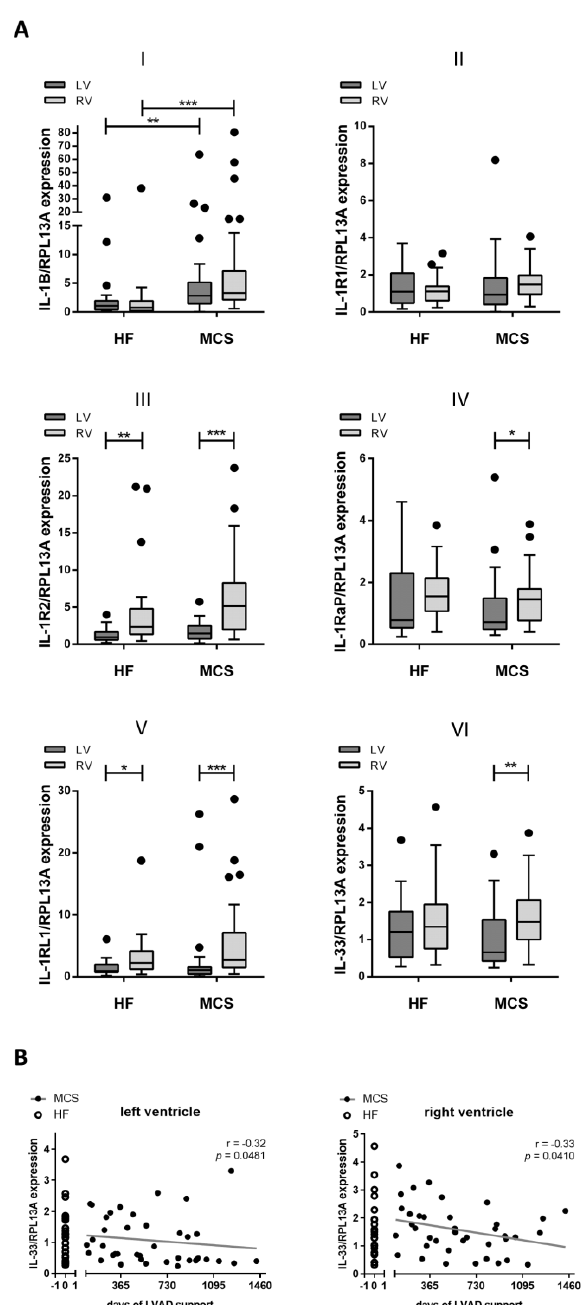
Figure 1. Significantly elevated IL-1B expression due to MCS (mechanical circulatory support). ( A ) Fold change of (I) IL-1B , (II) IL-1R1 , (III) IL-1R2 , (IV) IL-1RaP , (V) IL-1RL1 and (VI) IL-33 mRNA expression levels are displayed for patients with heart failure (HF) or MCS in left (LV) and right ventricular (RV) myocardial tissue. Data are presented as boxplots with whiskers (Tukey method). Significance of differences is calculated with Kruskal-Wallis-Test and Dunn’s post-hoc test and indicated with asterisks (* p < 0.05, ** p < 0.01, *** p < 0.001). ( B ) IL-33 expression levels are plotted against MCS duration and analyzed with Spearman correlation. Regression line is indicated in grey. VAD, ventricular assist device.